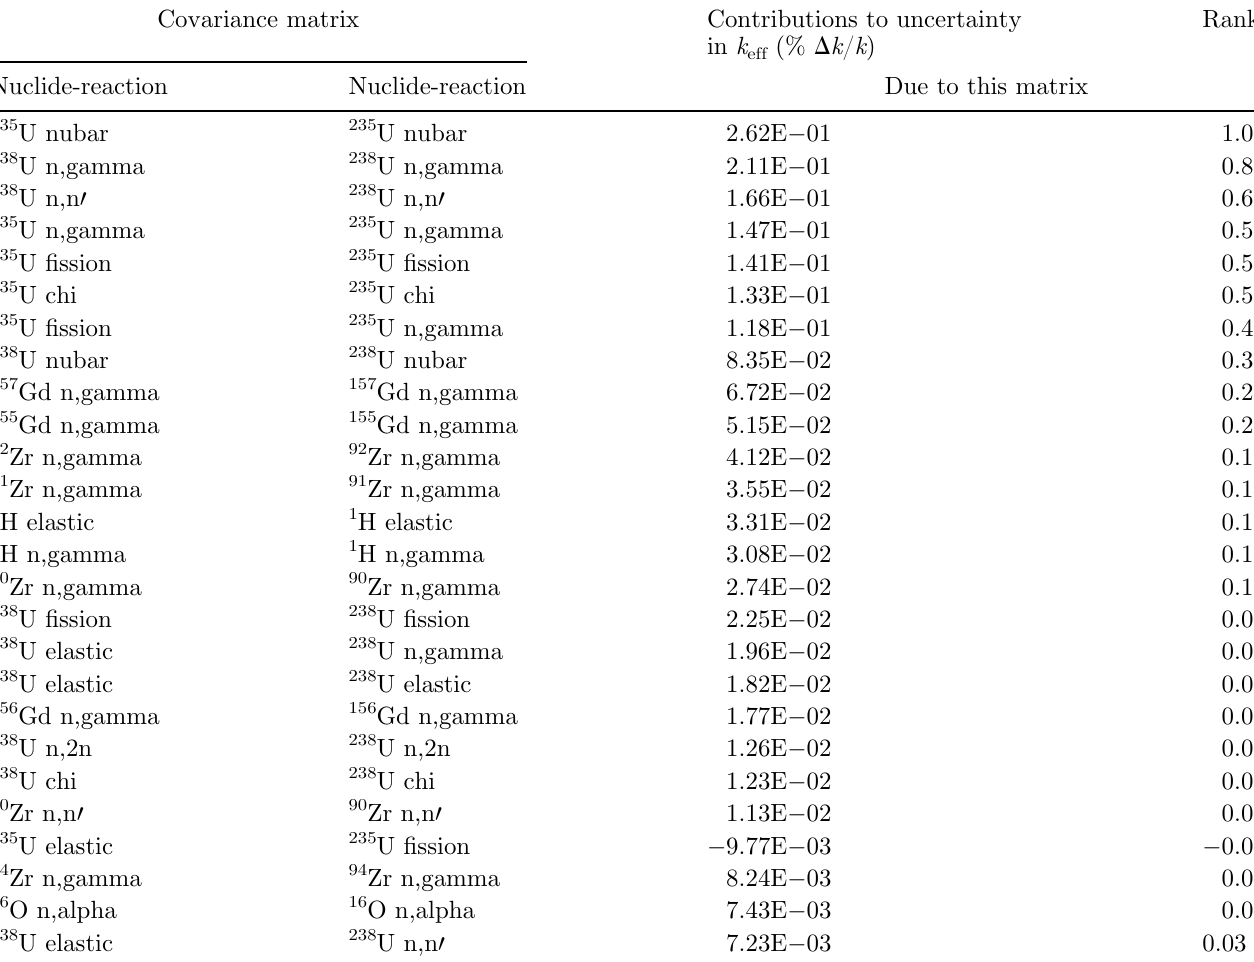
Rank (% D k / k ) in k eff